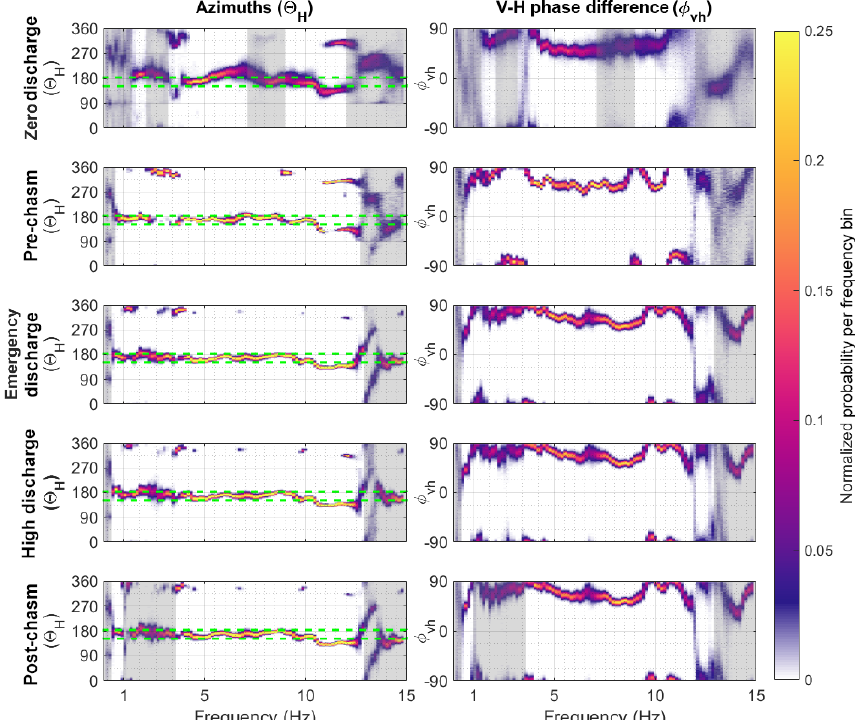
Figure 7. Two polarization attributes for the five time intervals of interest are presented in two-dimensional histograms. Dashed green lines in the left column indicates the azimuth range of the spillway relative to the seismometer (See Fig. 1). Each hour within the time interval of interest has a polarization value at 7201 frequencies. These are distributed among 100 bins evenly spaced in frequency, and are colored by normalized probability. The polarization attributes for the three intervals of interest after the spillway damage are similar, and differ dramatically from the attributes in the pre-crisis interval. Polarization attributes are interpretable only when the degree of polarization is sufficiently great ( β 2 >0.5). Regions shaded grey indicate frequencies at which β 2 <0.5 and the values are not